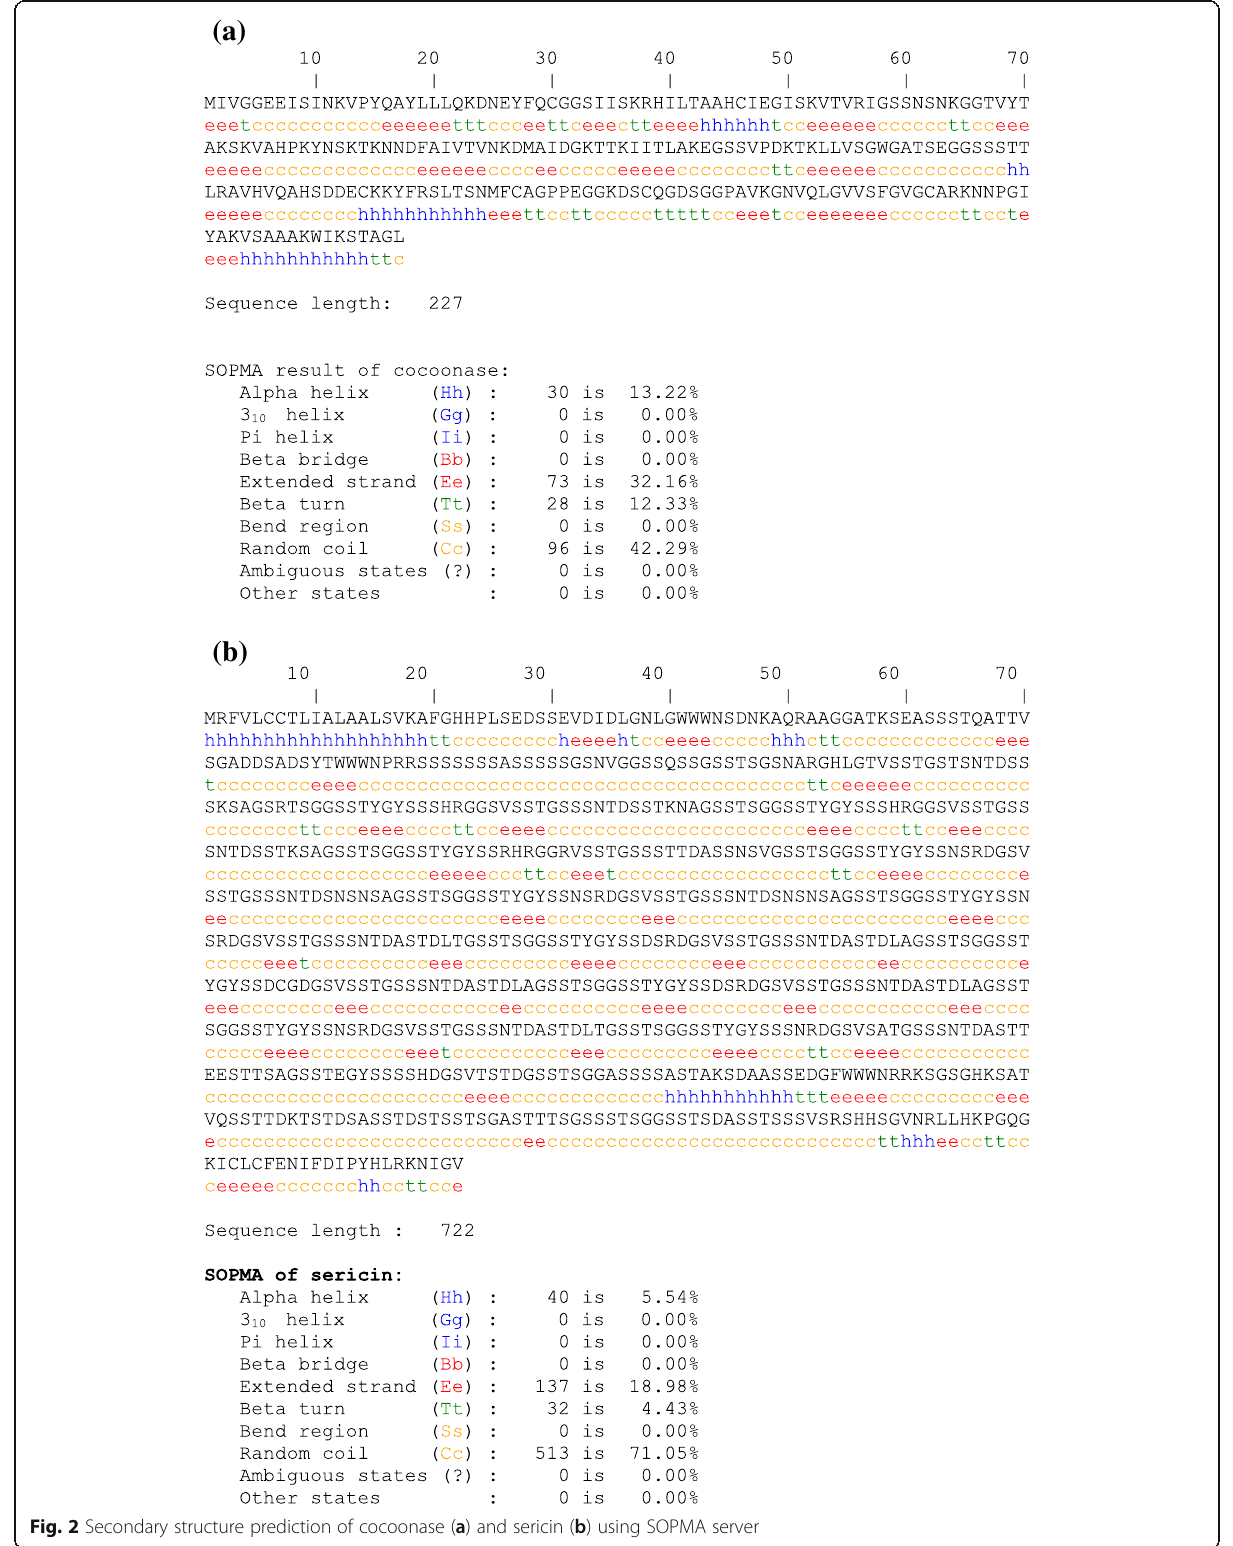
Fig. 2 Secondary structure prediction of cocoonase ( a ) and sericin ( b ) using SOPMA